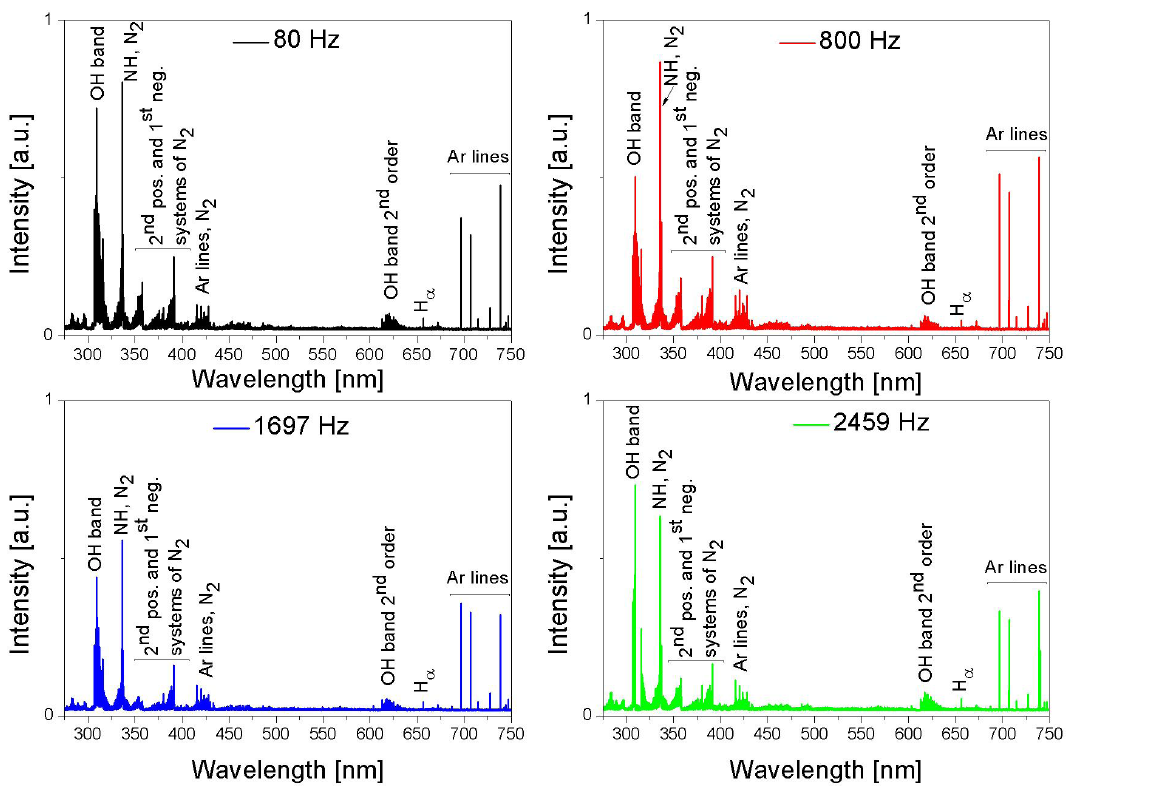
mixture subjected to 2